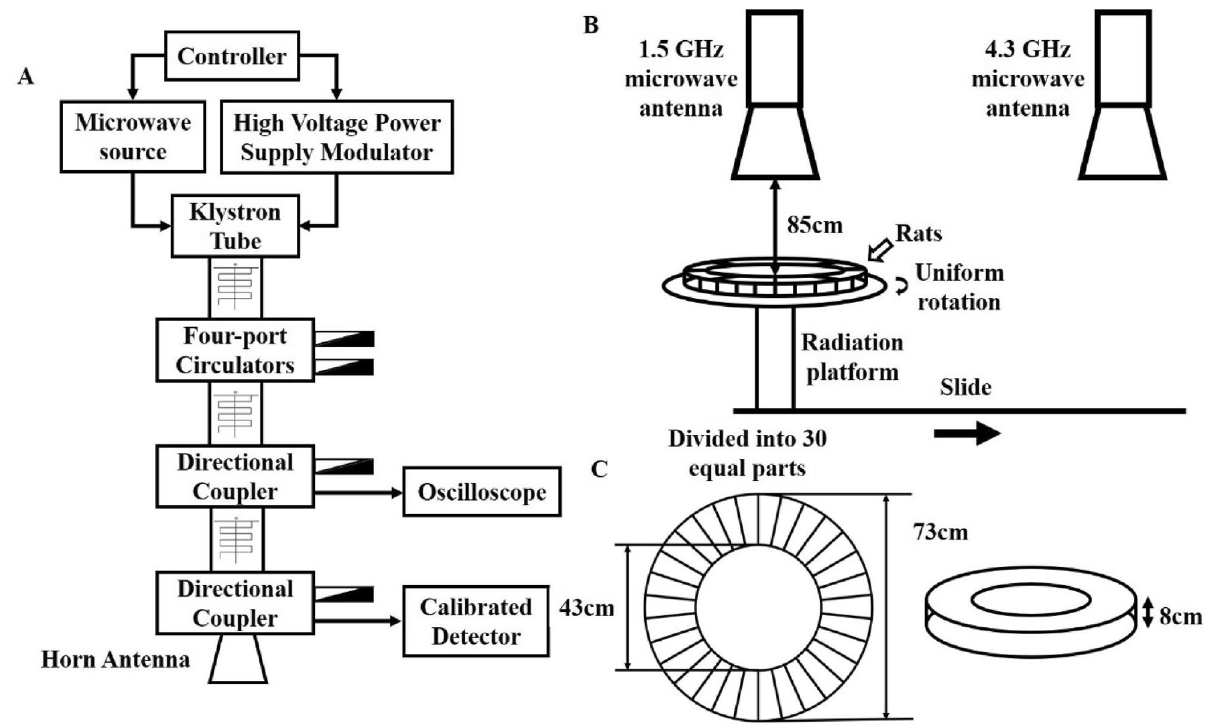
Figure 1. Schematic diagram of experimental set-up for microwave Exposure. ( A) Schematic diagram of microwave radiation source. ( B ) Schematic diagram of microwave radiation process. ( C ) Schematic diagram of rat